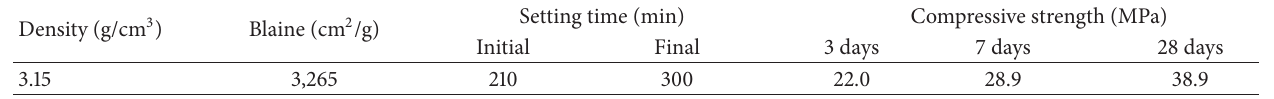
Table 5: Physical/chemical properties of cement.